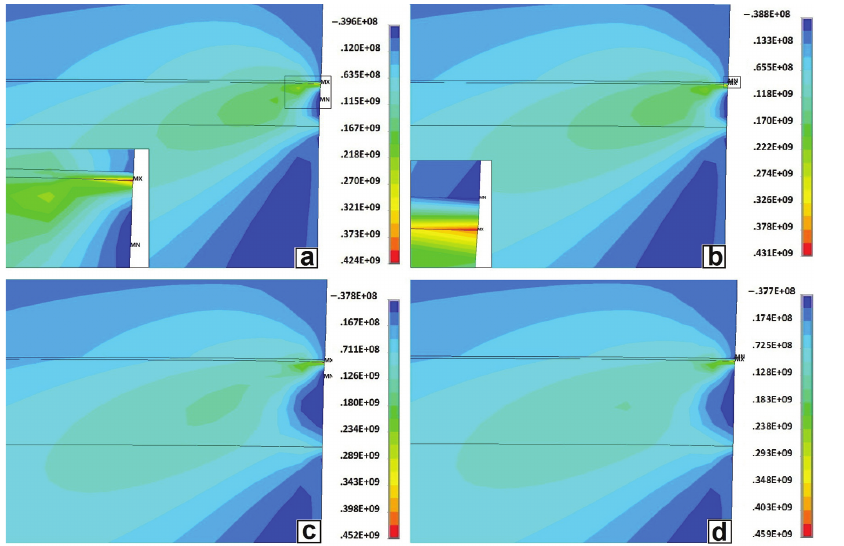
Figure 9: Contour plot of shear stress ( σ xy ) distribution in (left) traditional and (right) nanostructured YSZ coatings at 100 μ m (a, b) and 200 μ m (c, d) bond coat